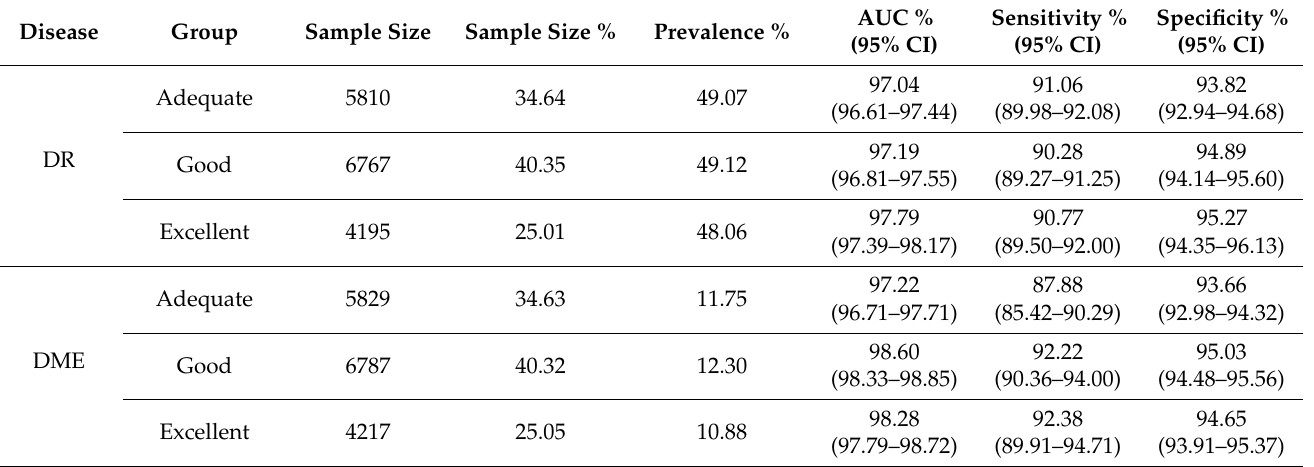
Table A7. Stratification results for the detection of referable retinopathy and diabetic macular edema on the patient level for image quality.